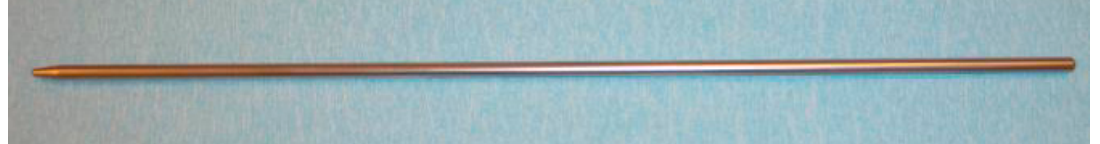
Figure 4. Conventional radiography showing the ingested magnets. During laparoscopy in routine technique (Video S2) with the patient in the French position and with a transumbilical minilaparotomy for a 10 mm trocar and two 5 mm trocars in the right and left lower quadrant, the all-round view showed normal upper and lower abdominal organs. Through the 10 mm trocar, a magnetic rod (Figure 5) was inserted intra-abdominally, and the entire small intestine was scanned starting from Bauhin’s valve.